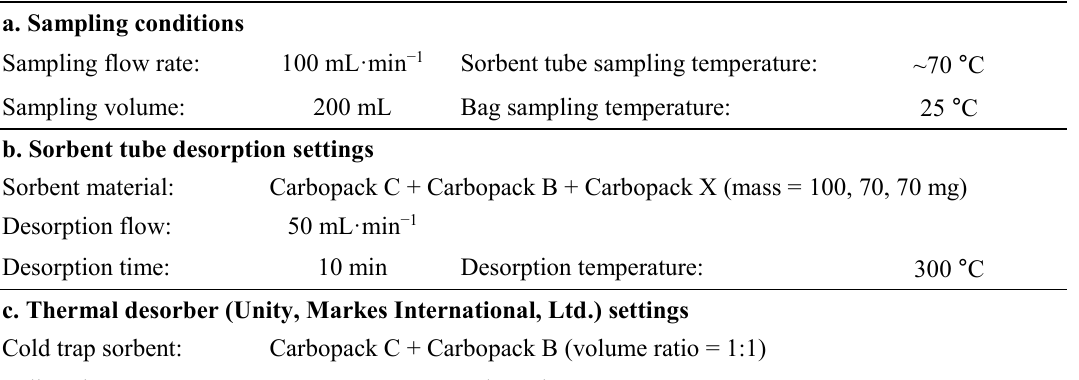
Table 3. The TD-GC-MS instrumental settings employed for the analysis of VOCs and odorants from fish cooking in this